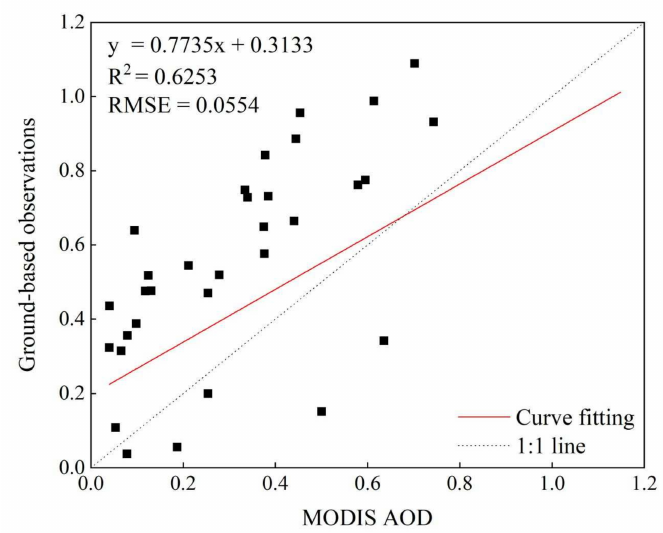
Figure 2. MODIS AOD data verification. The y -axis is the measured value of LiDAR in the Tazhong station, and the x -axis is the MODIS AOD value.